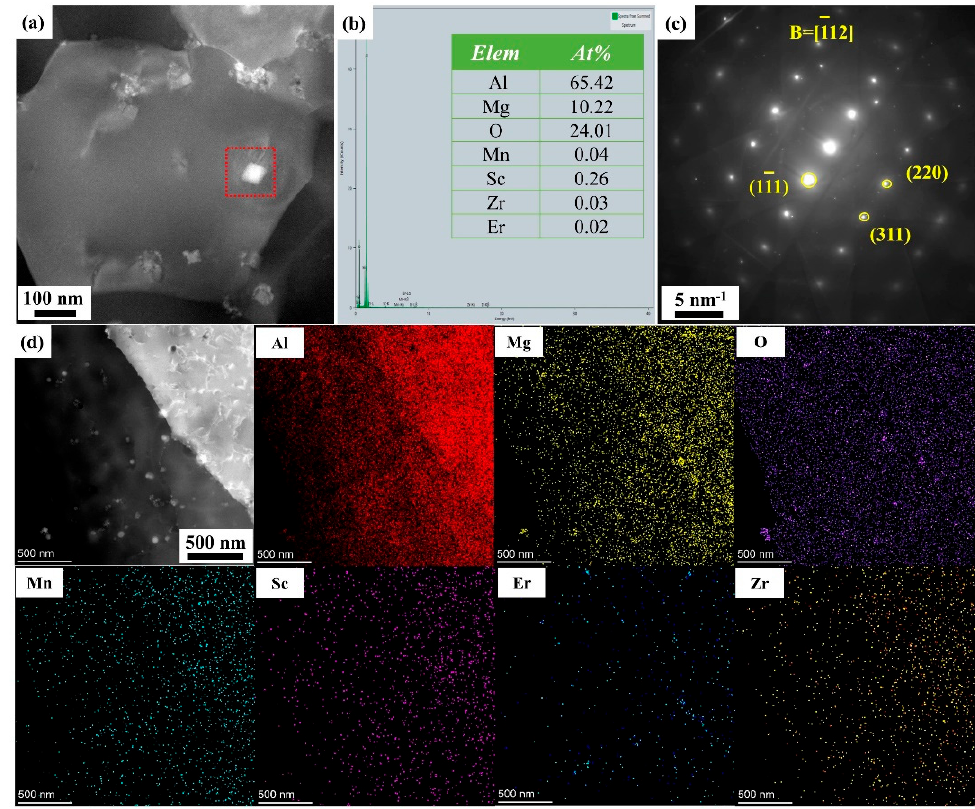
Figure 9. TEM images of Al 2 MgO 4 in as-built sample: ( a ) DF-STEM image of the FG region; ( b ) EDX results; ( c ) SAED; ( d ) BF-STEM image of the CG region and the corresponding STEM-EDX mapping analysis of Al, Mg, O, Mn, Sc, Er and Zr elements.